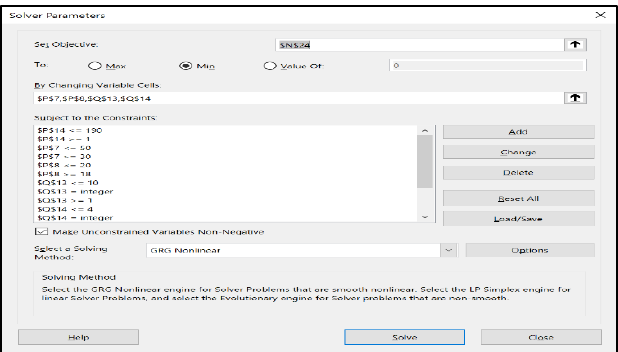
Fig. 1. Answer report of Microsoft excel solver